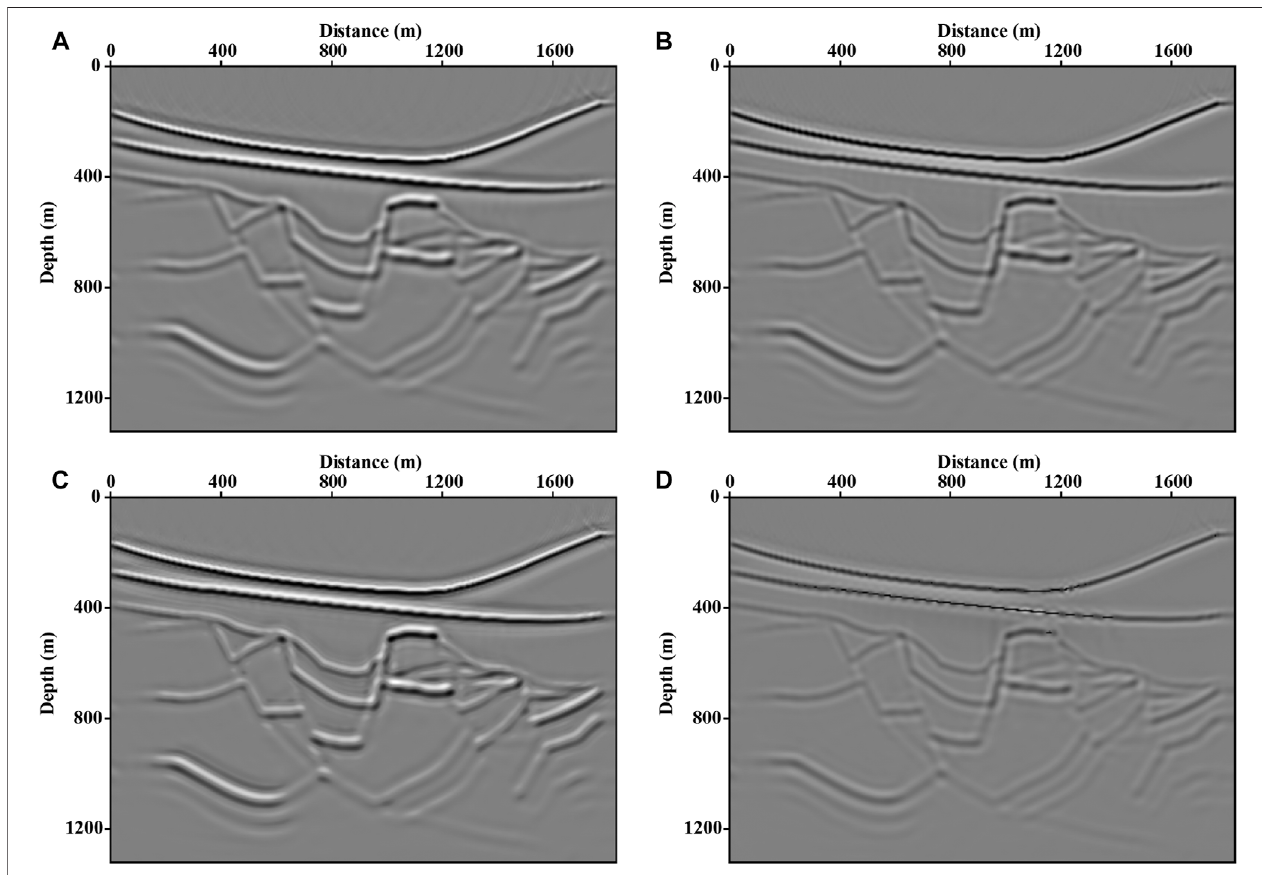
FIGURE 7 | Fault images inverted by (A) Unconstrained LSRTM based on Born approximation. (B) Unconstrained LSRTM with Kirchhoff approximation. (C) LSRTM with L1 norm regularization based on Born approximation. (D) sparse constrained LSRTM based on Kirchhoff approximation.